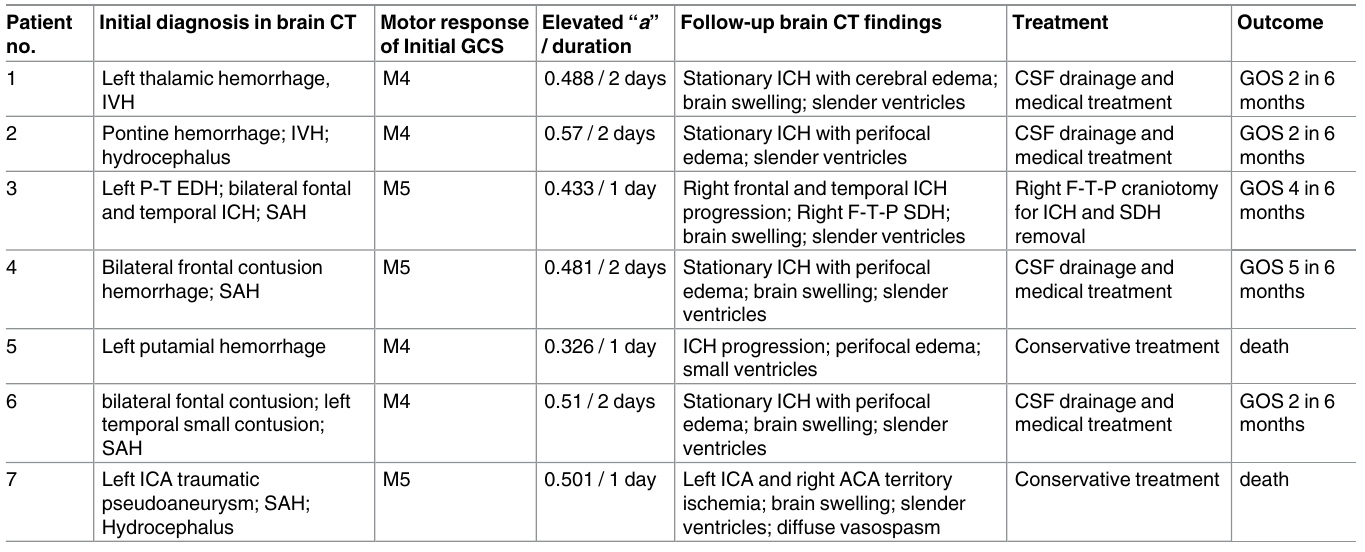
Table 4. Summary of clinical features in 7 patients with rapid elevation of indicator “ a ”. Patient